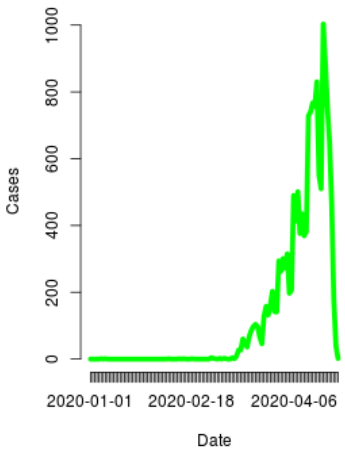
Figure 6. Daily evolution plot of cases presented in the population from all the territory.